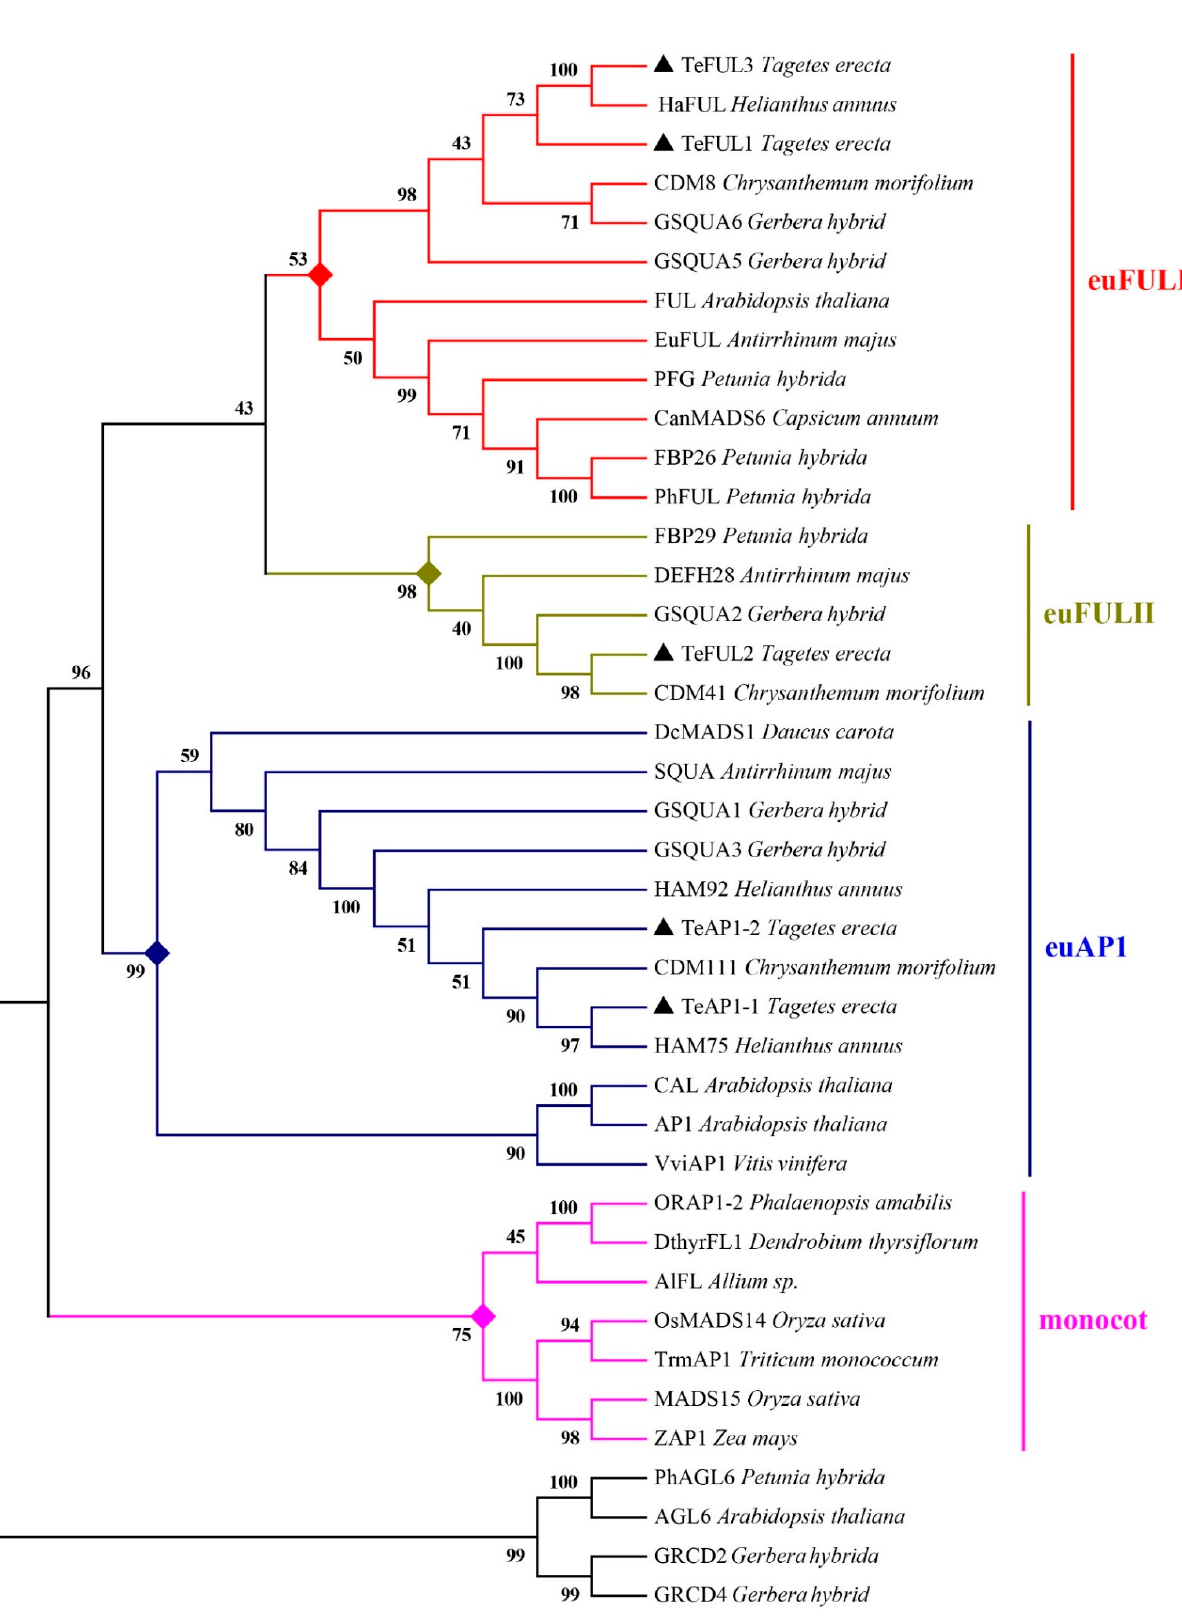
Figure 2. Phylogenetic tree based on the amino-acid alignment of TeAP1/FUL proteins. The tree was generated with the MEGA v7.0 software, using the neighbor-joining (NJ) method and 1000 bootstrap replicates. The TeAP1-1, TeAP1-2, TeFUL1, TeFUL2, and TeFUL3 are marked with black triangles.